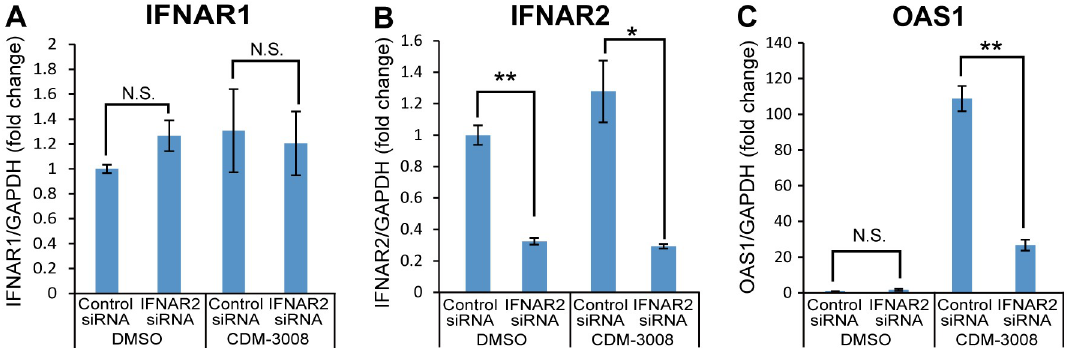
Fig 2. Suppression of ISGs expression after knockdown of IFNAR2. HCV replicon cells were treated with IFNAR2 siRNA for 2 days and incubated with CDM-3008 for 8 h. (A) IFNAR1 expression after control and IFNAR2 siRNA treatment. IFNAR1 expression was not suppressed by IFNAR2 siRNA treatment. (B) IFNAR2 expression after control and IFNAR2 siRNA treatment. IFNAR2 mRNA expression was suppressed by treatment with IFNAR2 siRNA but not by treatment with control siRNA. (C) OAS1 expression after control and IFNAR2 siRNA treatment. OAS1 mRNA expression was suppressed by treatment with IFNAR2 siRNA but not by treatment with control siRNA. The error bars in A-C indicate S.D. (n = 3). � , p < 0.05; �� , p < 0.01 (two-tailed t -test) in A-C.